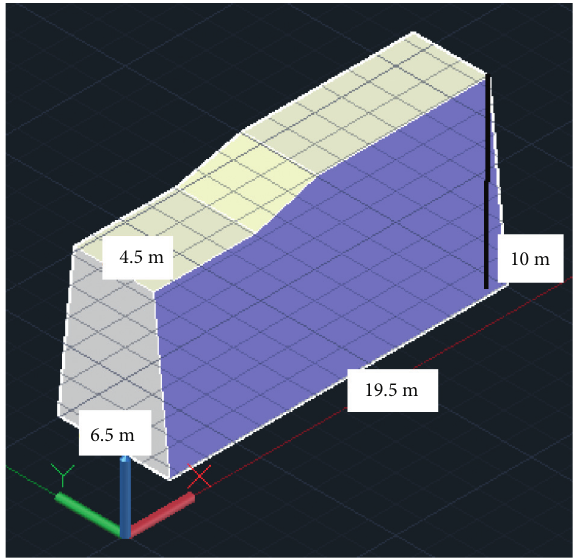
Figure 8: 3D model of the site wall. Table 3: The first three orders of modal frequencies for